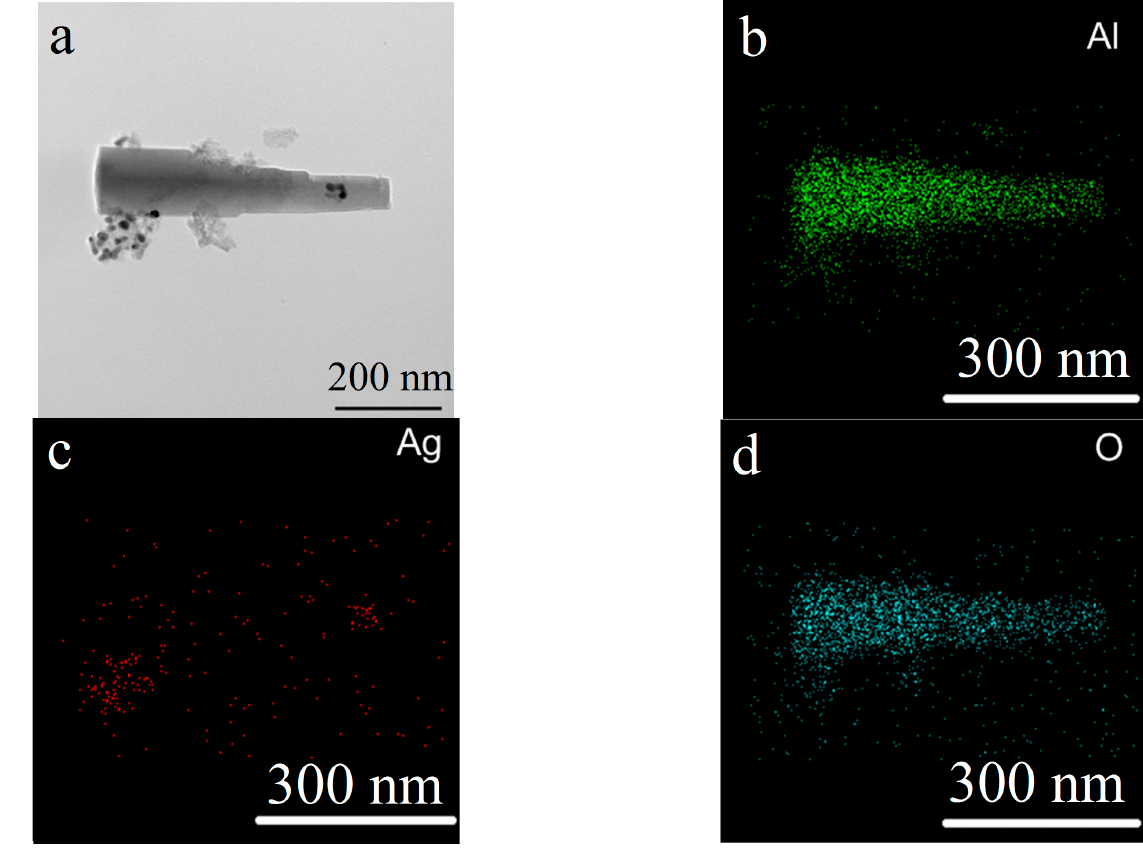
Figure 7. TEM image ( a ) and TEM-EDS mapping ( b – d ) of nanoscale structures obtained under HTO (sample 3). The main HTO product of the Al/Ag nanoparticles was boehmite (AlOOH) and sil- ver, with a standard lattice parameter (Figure 8). The formation of solid solutions was not observed, which may have been due to the harsher oxidation conditions. Under HTO